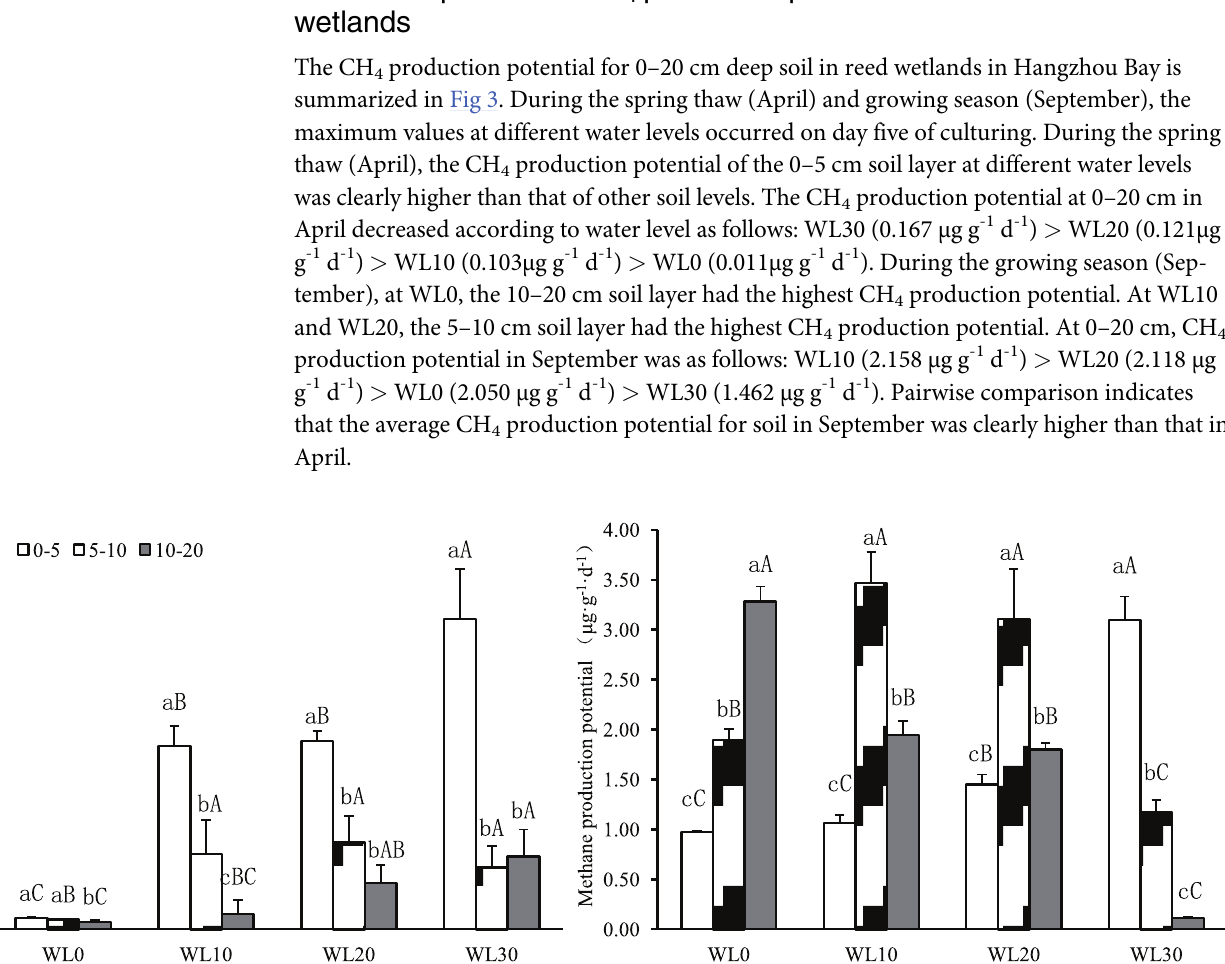
PLOS ONE | https://doi.org/10.1371/journal.pone.0185709 October 2,